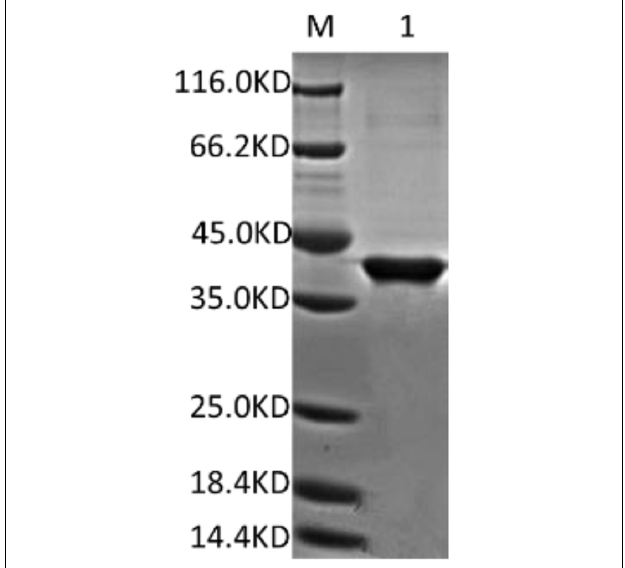
FIGURE 2 | SDS-PAGE of purified recombinant DpWRI1-like. The recombinant protein DpWRI1-like containing a His-Tag was purified by Ni 2 + -NTA column, and then SDS-PAGE of purified DpWRI1-like (17.2 µ g) was performed.